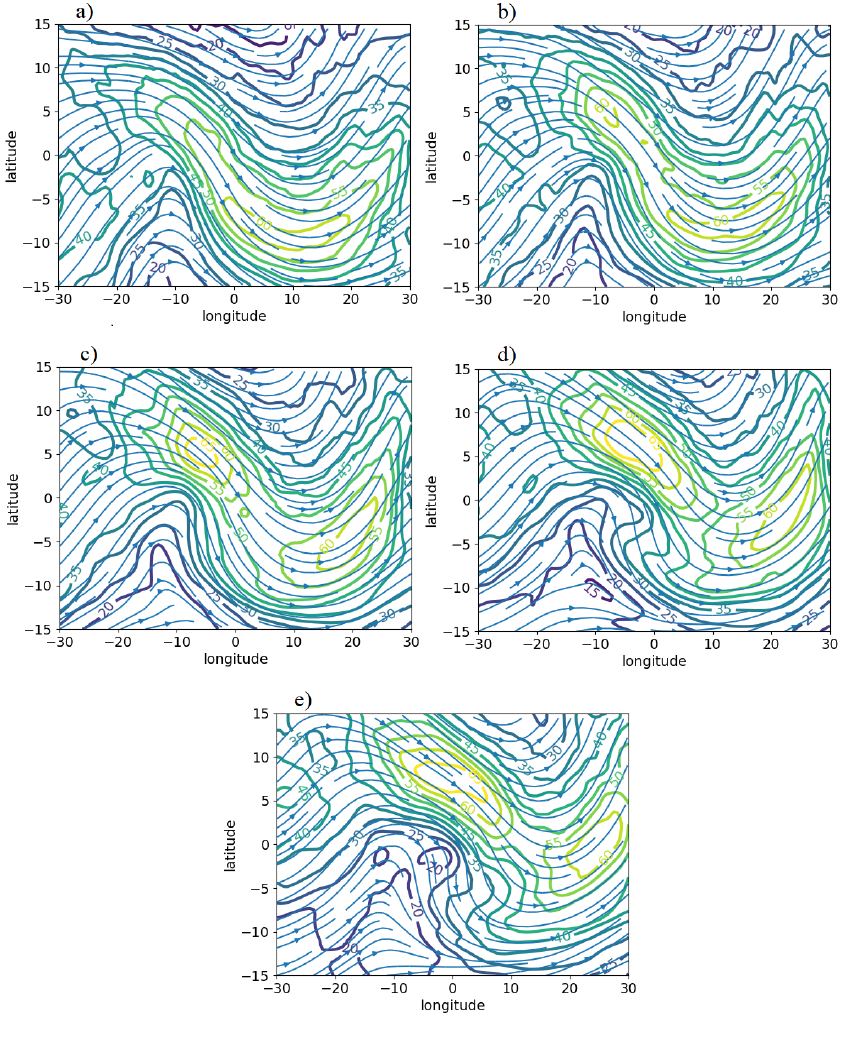
Figure 7. Composite fields of wind magnitude at 250 hPa with 5 m/s intervals (colored solid lines) and streamlines at 250 hPa (blue thin lines) for intense cases: a) t0 (beginning of explosive phase); b) t1; c) t2; d) t3; e) t4 (end of explosive